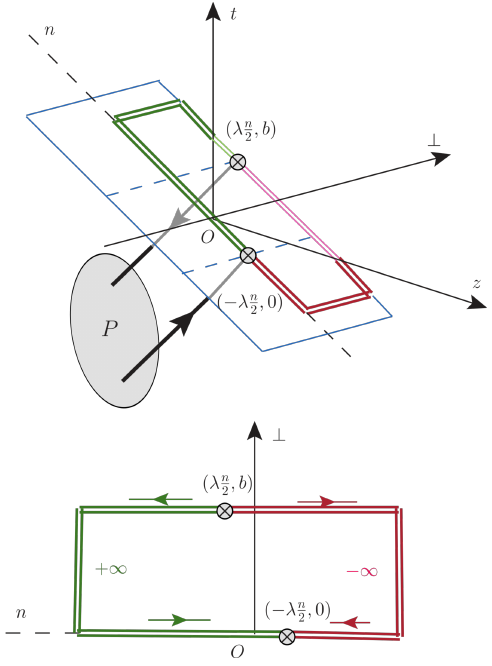
Figure 1 . The Wilson line structure in the TMDWF, where the red line show the Wilson line in the − direction, and the green line show the Wilson line in the + direction. All the Wilson lines are in the n − ⊥ plane which show in blue, and the two end points of Wilson line are given by the position (+ , ⊥ )